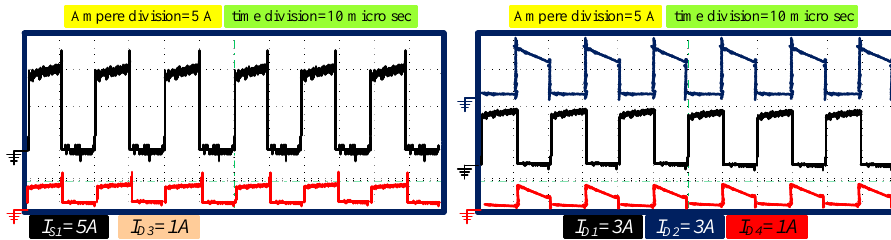
experimental results.